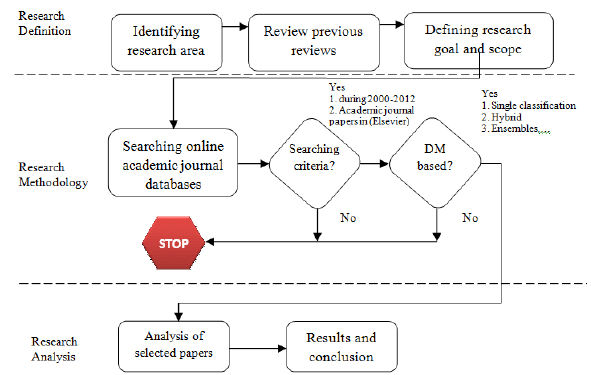
Figure 1. Methodological framework of research